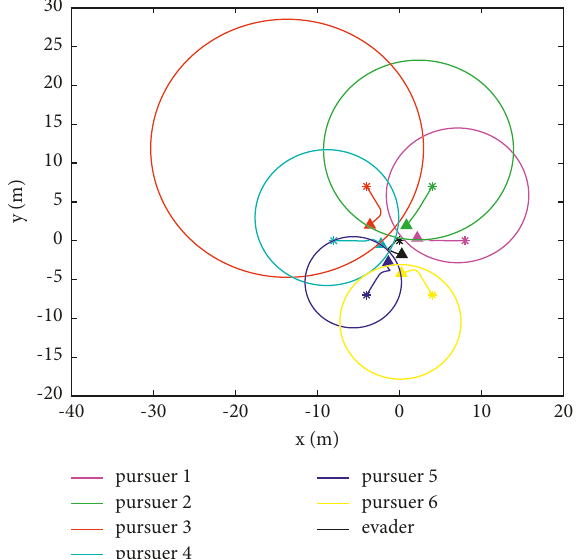
Figure 6: Trajectories of players with the pursuit strategy proposed in [8] ( N � 6, λ � 0 . 85). The pursuers cannot capture the